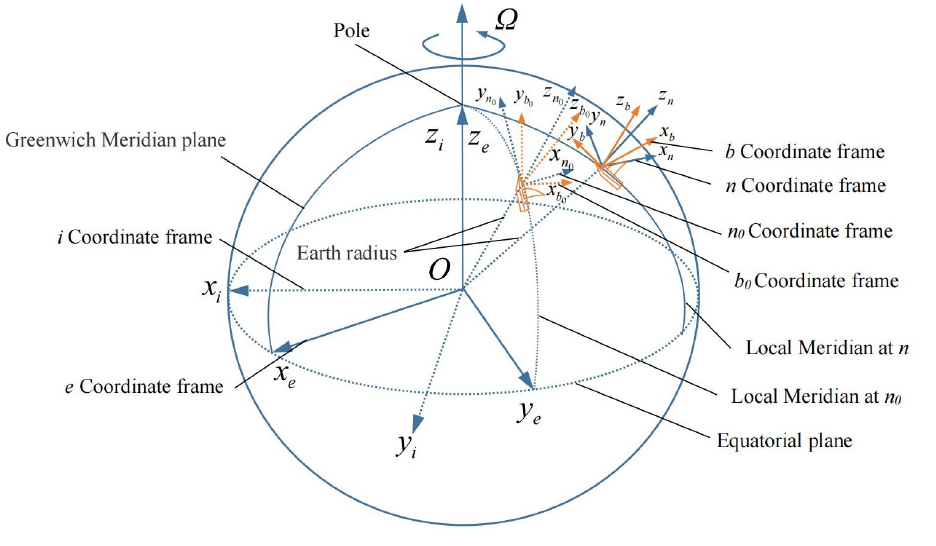
Figure 1. The reference coordinate frames involved in this